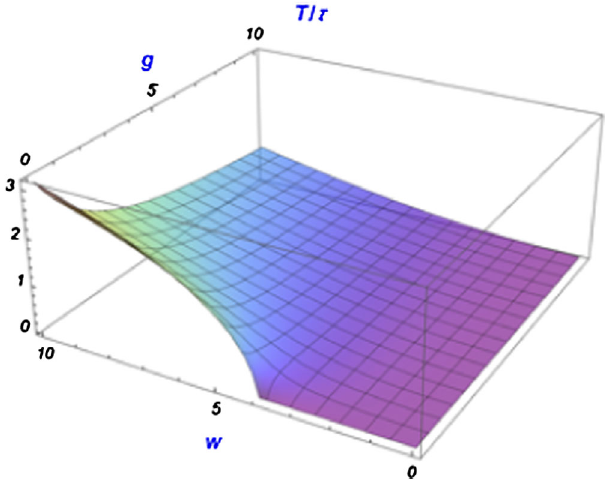
FIG. 2. The same as Fig. 1, but for the resistive damper.